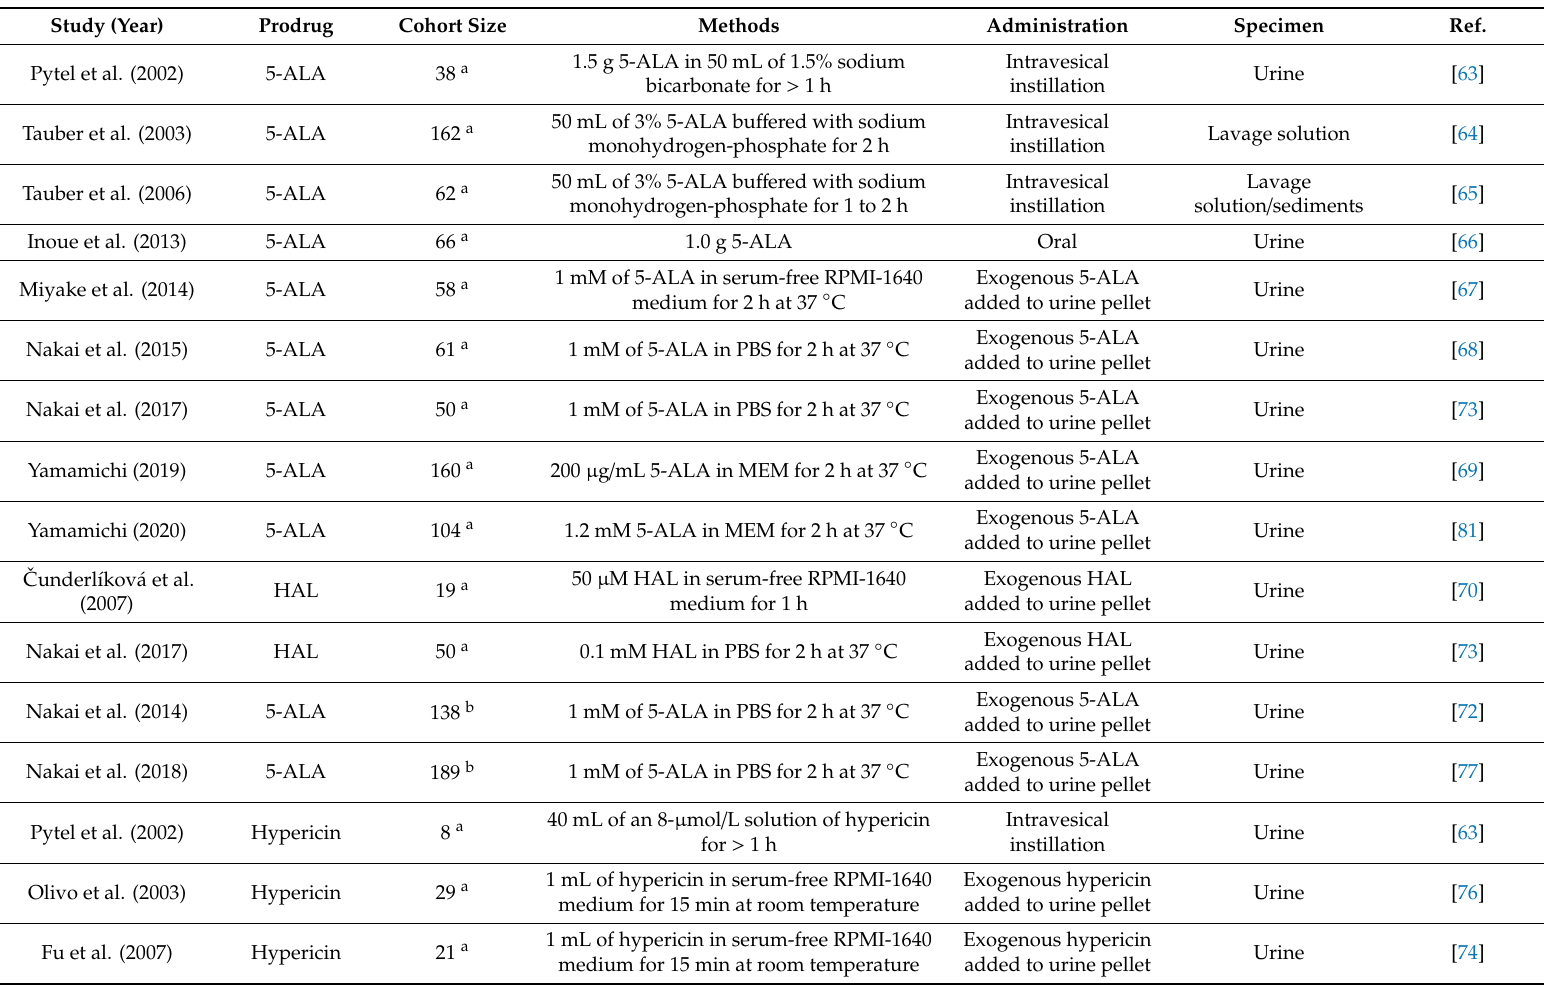
Table 4. Studies of prodrug application ex